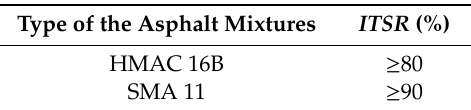
Table 5. Polish Technical Requirements WT-2 for the resistance of asphalt mixtures to water and frost for HMAC 16B and SMA